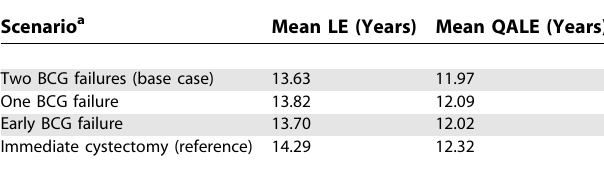
Table 3. Impact of Alternative Triggers for Radical Cystectomy during Initial BCG Therapy Scenario